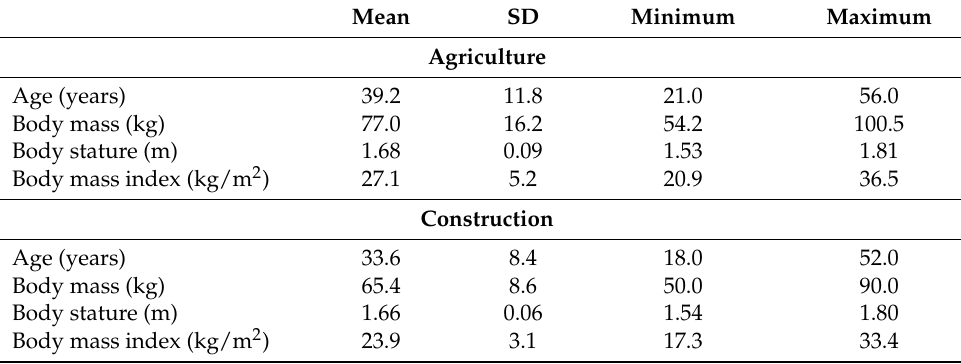
Table A7. Anthropometric characteristics of the participants in Study